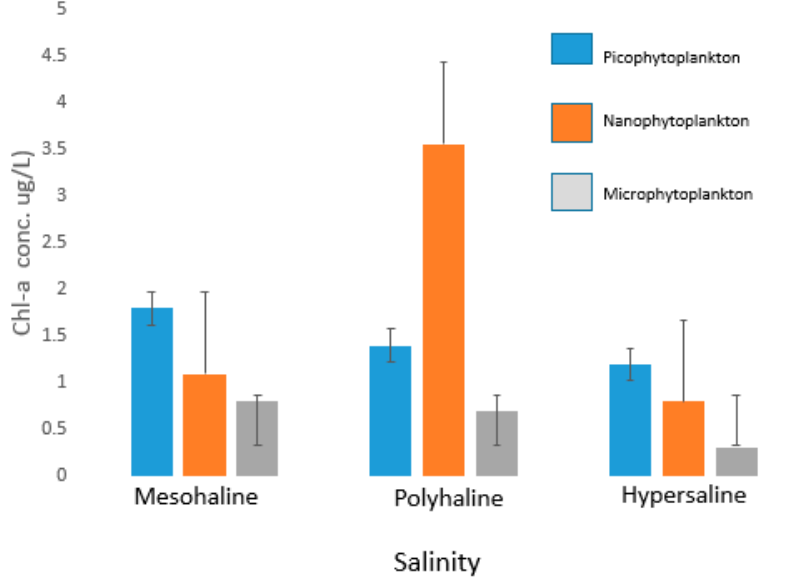
Figure 2. Size-fractionated total chlorophyll-a concentration during the three salinity regimes of the temporarily open/closed Kasouga Estuary on the southeastern coastline of South Africa. Error bars are standard deviation (n = 3).